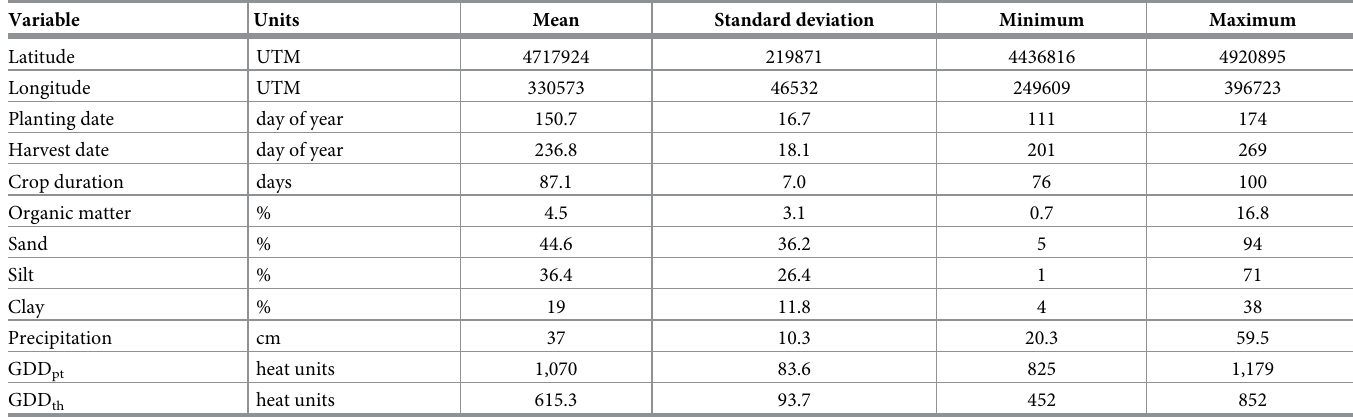
Table 2. Summary statistics of the environmental and crop management variables of thirty fields in which optimum plant density for processing sweet corn was quantified in field trials in Illinois, Minnesota, and Wisconsin from 2013 to 2017. Universal Transverse Mercator (UTM) uses a 2-dimensional Cartesian coordinate system to give locations on the surface of the Earth. GDDpt and GDDth represent growing degree days observed during planting-tassel and tassel-harvest, respectively.